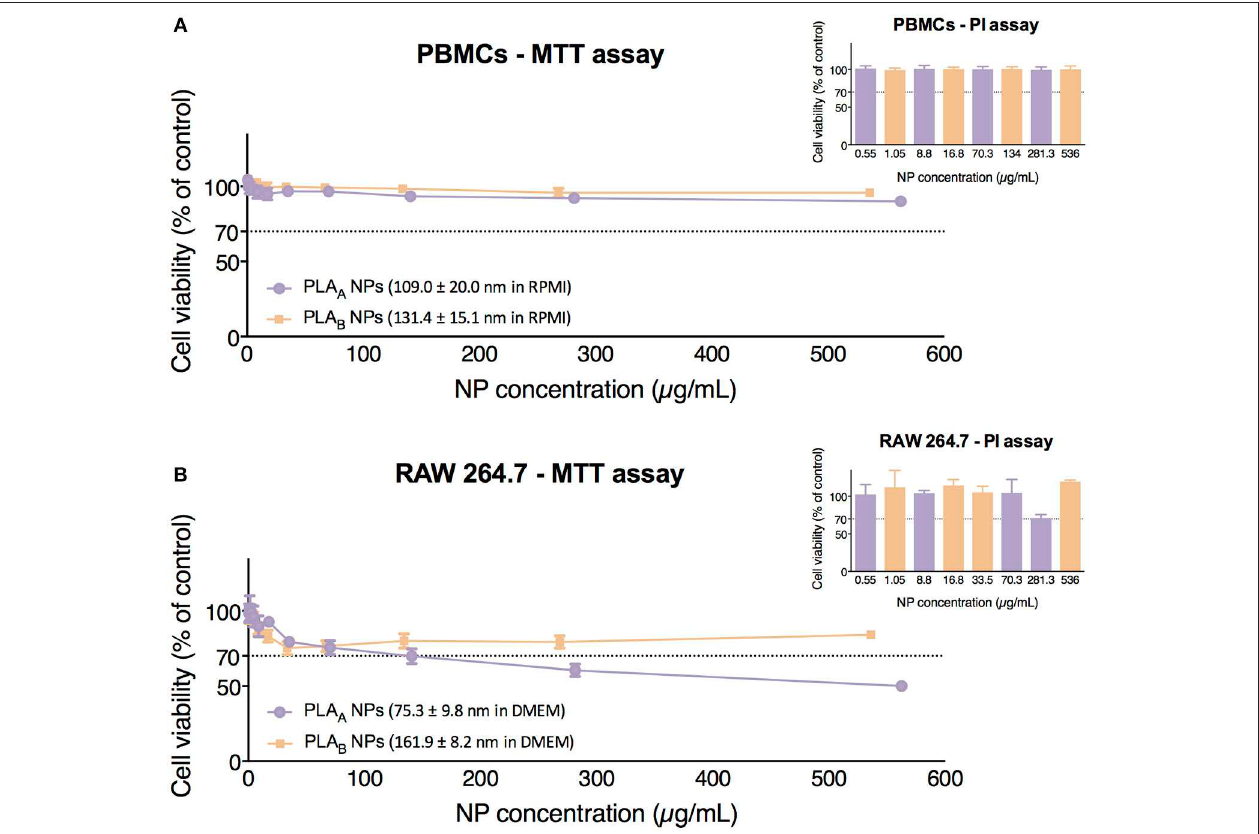
FIGURE 4 | Cytotoxicity assays (MTT and PI) performed in PBMCs (A) and in RAW 264.7 cell line (B) after 24h of incubation with PLA NPs. Data are presented as mean ± SEM, n ≥ 4 (four or more independent experiments, each in triplicate). mean diameter of 10 nm. However, in PBMCs, both PLA